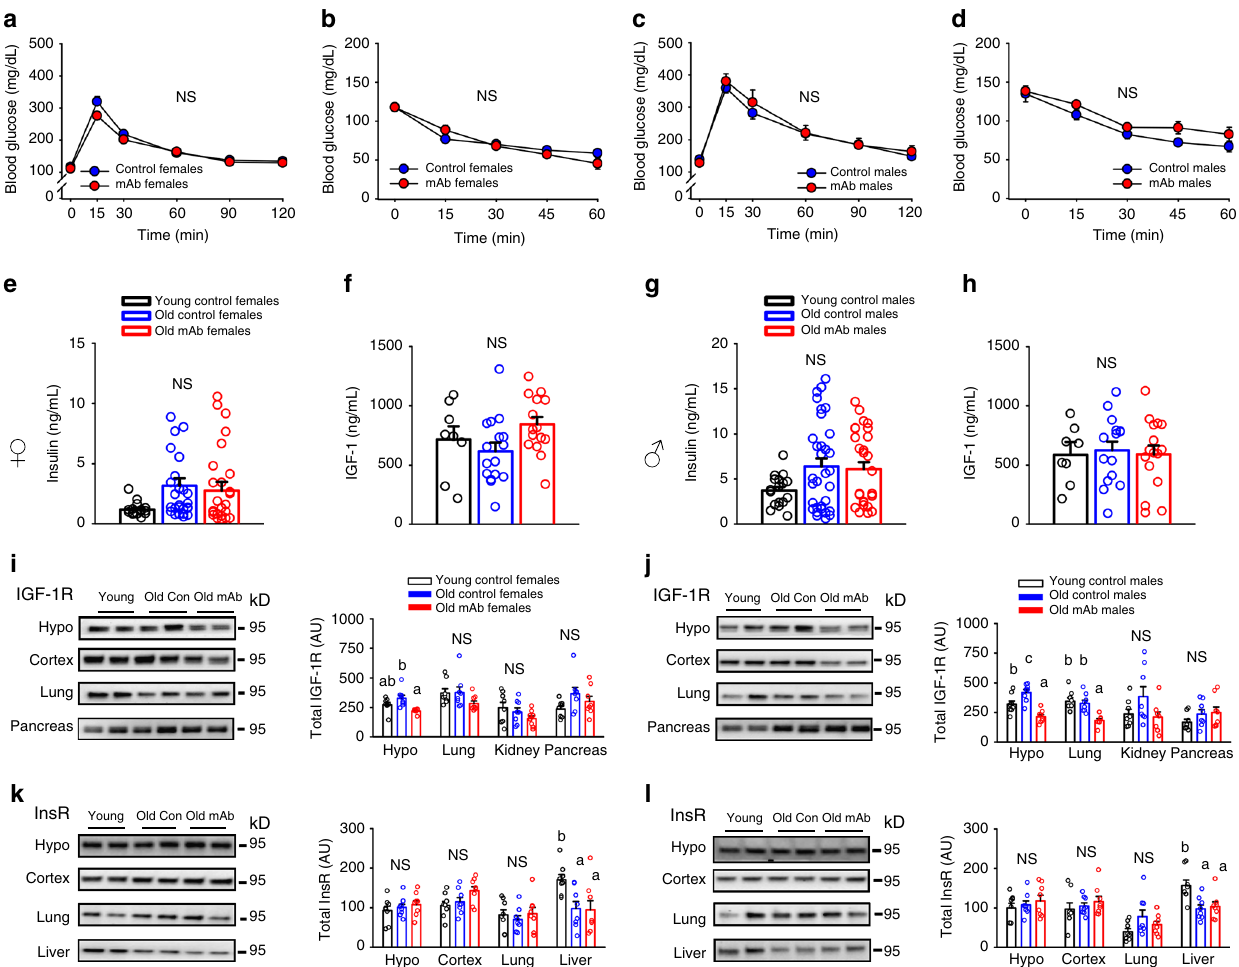
Fig. 2 L2-Cmu does not perturb glucose homeostasis in aged mice. a – d Glucose and insulin tolerance in 24-mo-old female and male mice is not adversely effected by 6 mo mAb treatment ( n = 12 per group, per sex). e – h Chronic L2-Cmu treatment led to a non-signi fi cant (main effect, P = 0.097), numerical increase in plasma IGF-1 level in old females [Young ( n = 8), Old Con ( n = 16), and Old mAb ( n = 15)], while no signi fi cant difference was observed for IGF-1 levels in male mice [Young ( n = 8), Old Con ( n = 15), and Old mAb ( n = 16)]. Likewise, insulin levels were not signi fi cantly different in female [Young ( n = 16), Old Con ( n = 26), and Old mAb ( n = 25)], or male mice [Young ( n = 17), Old Con ( n = 32), and Old mAb ( n = 28)]. i , j L2-Cmu treatment in males and females prevented the age-related increase in hypothalamic IGF-1Rs and reduced cortical levels in males only ( P ≤ 0.05), but had no effect on IGF-1Rs in lung or pancreas of either sex. k , l Further, L2-Cmu treatment had no effect on InsR levels in examined tissues of either sex ( n = 8 per group, per sex). Bars represent mean ± s.e.m. Dot plots overlaid on bar graphs represent individual data points. NS not signi fi cant. Different letters denote a signi fi cant difference between groups by Tukey HSD, P ≤